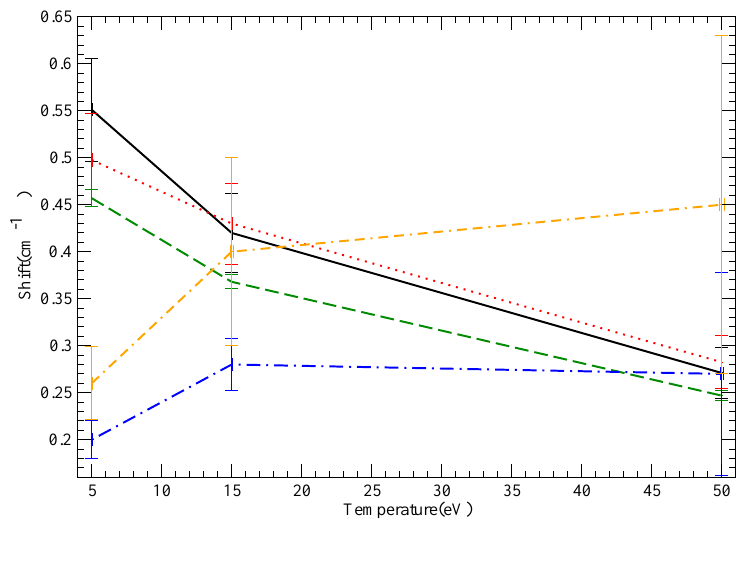
A comparison of LiI 2s-2p transition shifts as computed by SCP (solid black), SimU (dotted red), Simulation (dashed green) and Starcode with (dash-dotted blue) and without (dot-double dash orange) penetration accounted